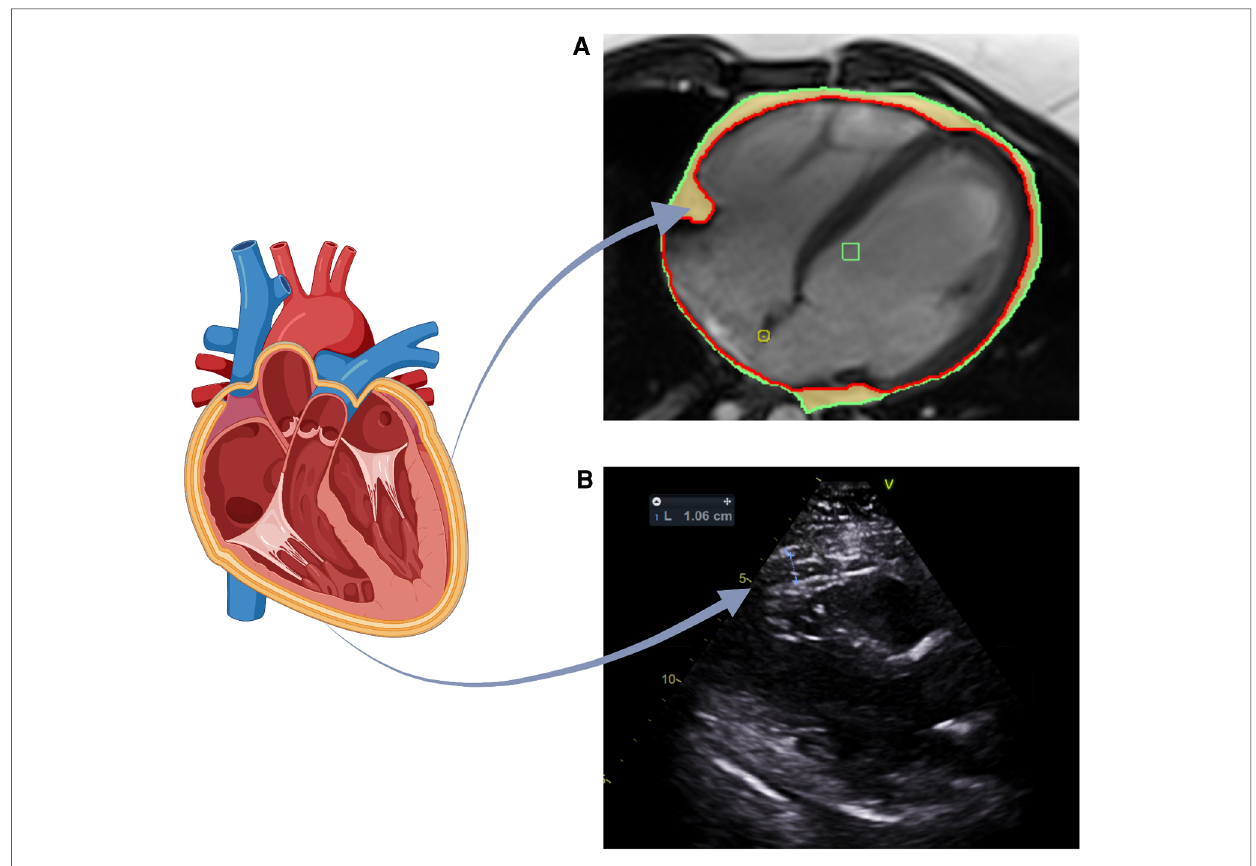
FIGURE 4 Assessment of EAT utilizing TTE and CMR ( A ) EAT volume assessed by CMR. EAT is de fi ned as the adipose tissue between epicardium and pericardium. Long axis 4-chamber view: red line marks the epicardium, green line marks the pericardium and highlighted in yellow is the EAT. ( B) EAT volume assessed by TTE. Parasternal long axis view used to measure EAT thickness anterior to the right ventricular free wall. The images shown for each technique were acquired from our institute (St Vincent ’ s Hospital Sydney, Australia) with ethics